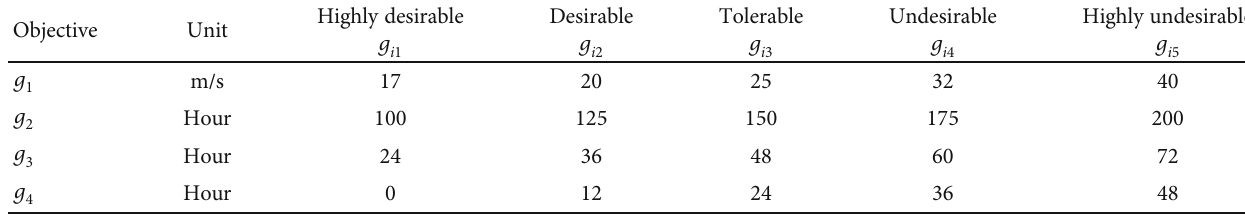
Table 2: Details of the region end points for Class